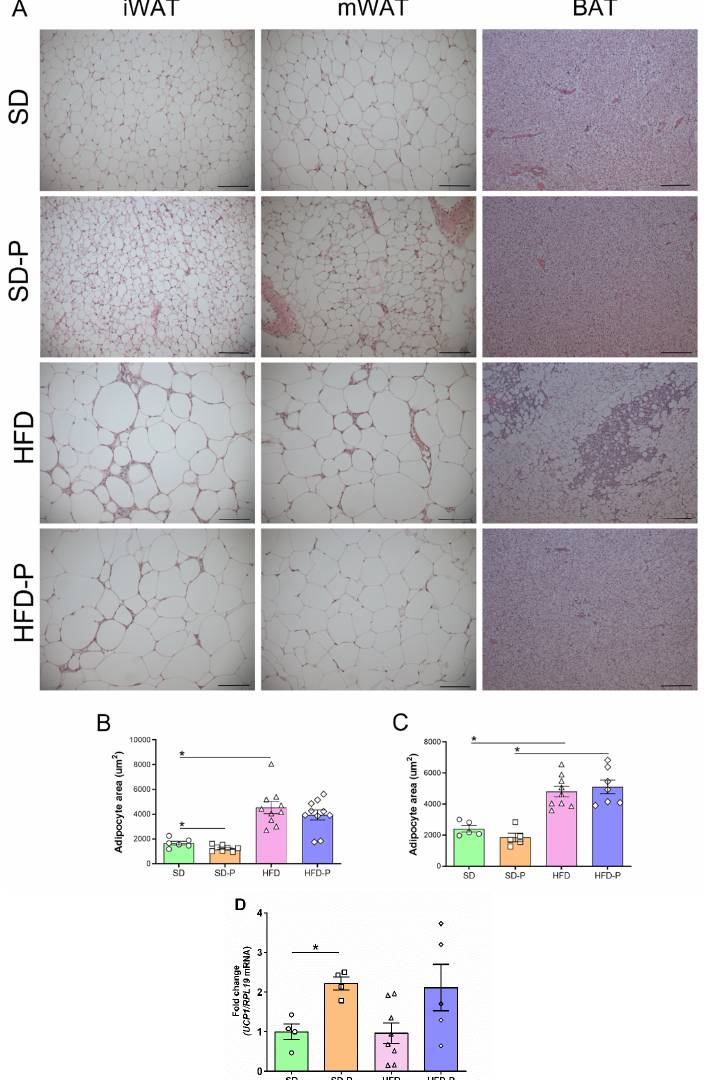
Figure 4. Effects of Pep19 treatment on adipose tissue morphology. ( A ) H&E-stained representative images of inguinal white adipose tissue (iWAT), mesenteric white adipose tissue (mWAT) or